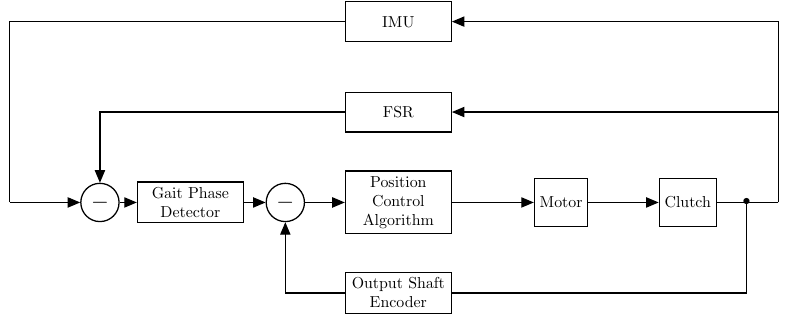
Figure 7. Control scheme for a synergy-based